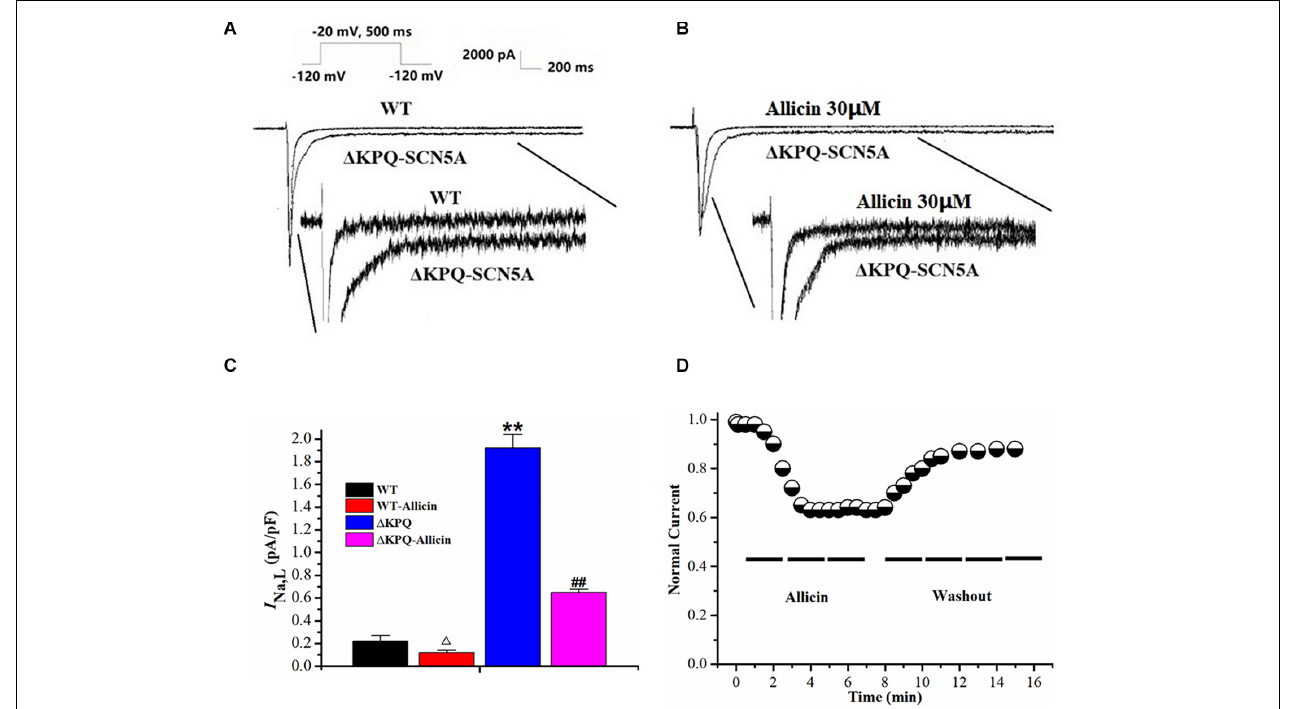
FIGURE 1 | Effect of Allicin on the I Na , L of the (cid:49) KPQ-SCN5A mutation. (A,B) Representative current traces recorded. I Na , L of (cid:49) KPQ-SCN5A was significantly larger than that of WT, which was inhibited by Allicin. (C) Current densities of the I Na , L in four groups were shown. I Na , L of (cid:49) KPQ-SCN5A was decreased by 30 µ M Allicin from 1.92 ± 0.12 to 0.65 ± 0.03 pA/pF. (D) Time course of the I Na , L of (cid:49) KPQ-SCN5A inhibition by 30 µ M Allicin and washout effect ( n = 15). ** P < 0.01 vs. WT group; ## P < 0.01 vs. (cid:49) KPQ